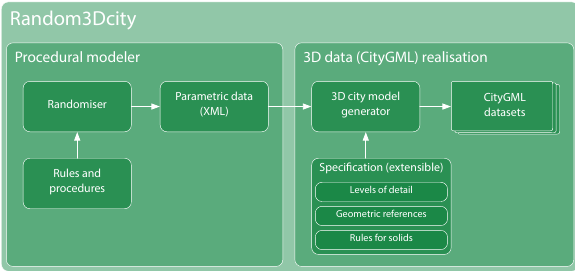
Figure 3: Modular workflow of the engine R ANDOM 3D CITY